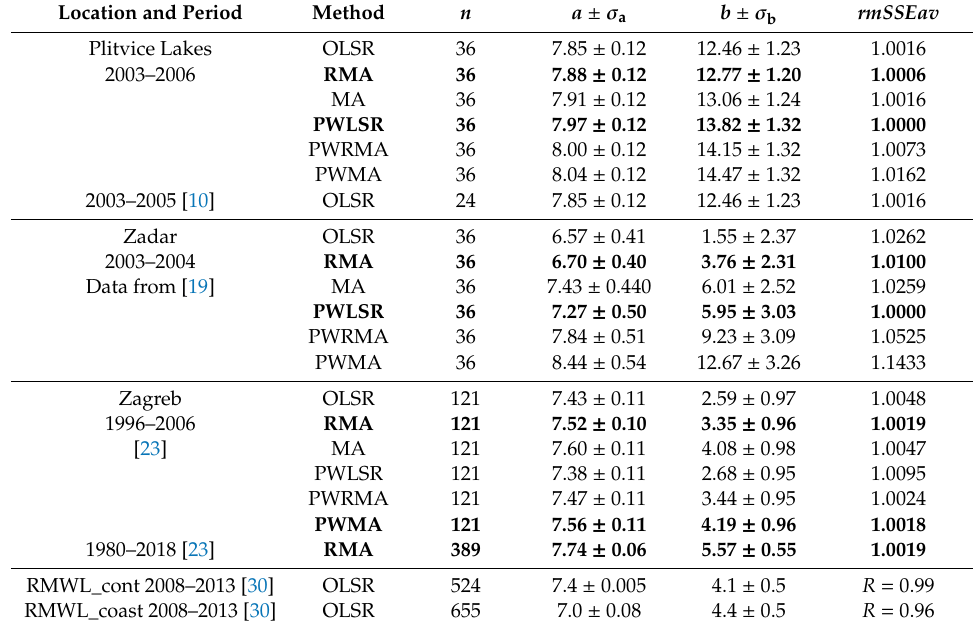
Figure 5. Tritium activity concentration in the precipitation at Zagreb and Plivice Lakes for the 1978–1984 and 2003–2006 periods. Table 3. Values of slopes ( a ± σ a ) and intercepts ( b ± σ b ) for LMWLs obtained by di ff erent regression methods for precipitation at the Plitvice Lakes, Zadar, and Zagreb. OLSR: ordinary least squares regression; RMA: reduced major axis regression; MA: major axis least squares regression; PWLSR, PWRMA, and PWMA: precipitation-weighted respective regressions; n —number of data points included; rmSSEav —average of the root mean square sum of squared errors [60]. In bold: approaches that describe LMWL the